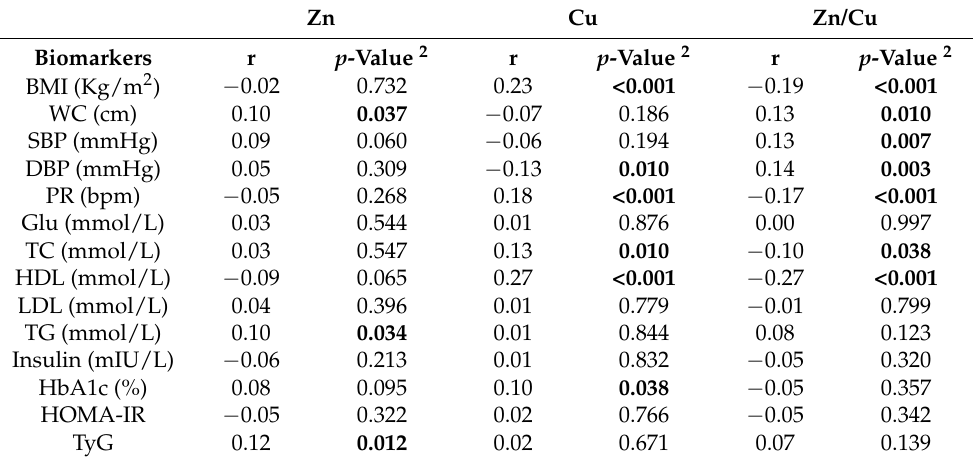
Table 3. Partial Correlation between cardiometabolic indicators and trace minerals (Zn, Cu, and Zn/Cu) 1 . Zn